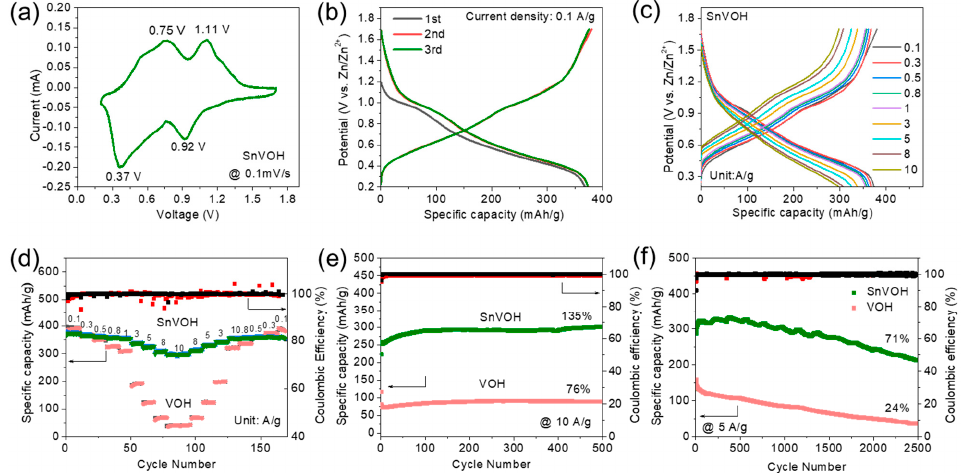
Figure 2. Electrochemical performance of VOH and SnVOH. ( a ) C–V curves at 0.1 mV/s in the voltage range of 0.2–1.7 V vs. Zn 2+ /Zn, ( b ) corresponding GCD curves, ( c ) representative galvanostatic charge–discharge curves at different current densities, ( d ) rate capacities at current densities between 0.1 to 10 A/g, ( e ) cycling performance at 10 A/g and ( f ) cycling performance at 5 A/g for the VOH and SnVOH